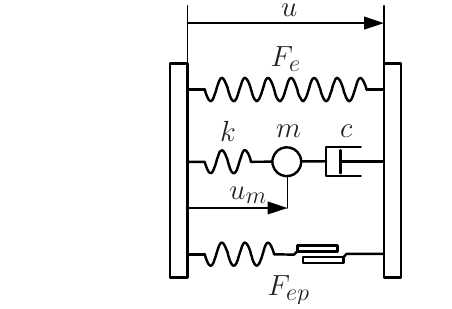
Figure 4: Graphical representation of hydro dynamic